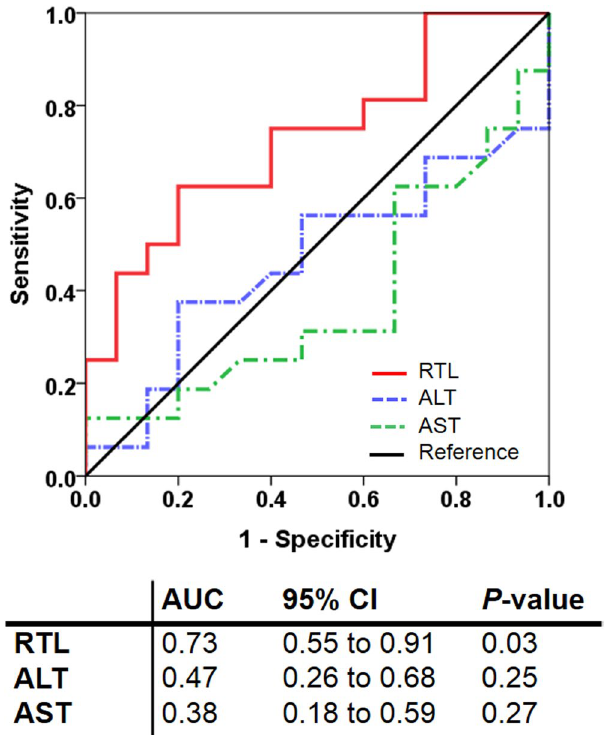
Figure 3. ROC revealing a diagnostic value of RTL as an ATDILI biomarker. Leukocyte RTL cloud be used as an early biomarker for distinguishing tuberculosis patients with ATDILI from non-ATDILI. Abbreviations: ATDILI, anti-tuberculosis drug-induced liver injury; ROC, receiver operating characteristic; RTL, relative telomere